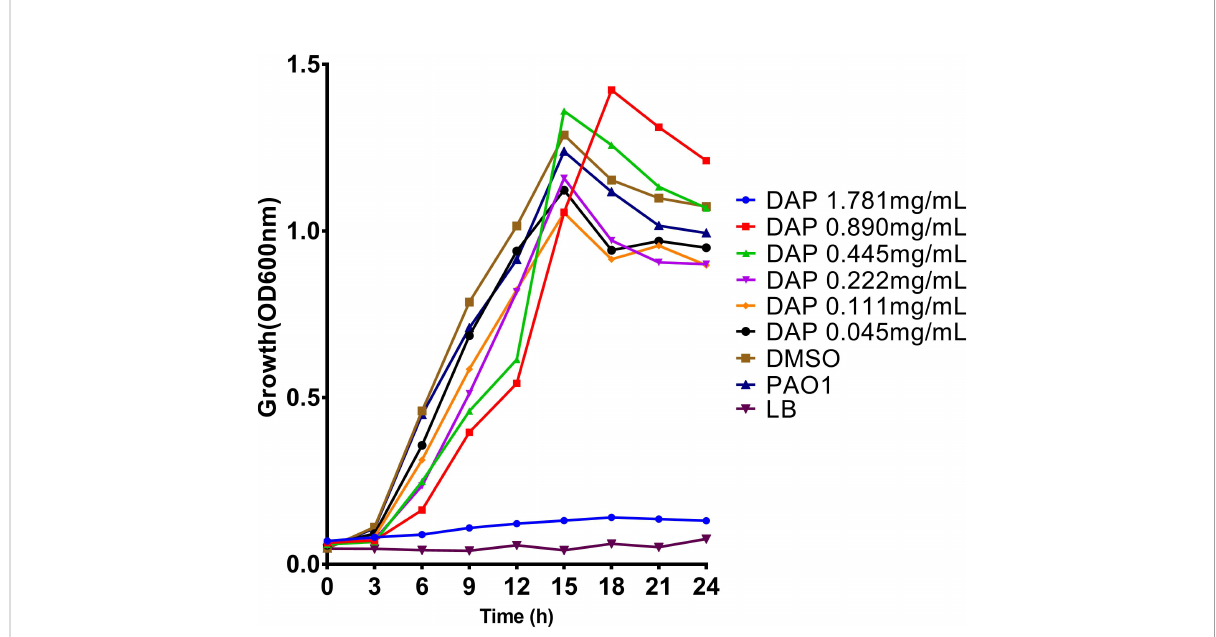
FIGURE 2 Effect of daphnetin (DAP) on the growth of P. aeruginosa within 24 h. Growth curves of P. aeruginosa PAO1 treated with different concentrations of DAP (0.055 – 1.781 mg/mL) in LB broth at 37°C for 24 h. The error bars represent the standard error of the OD 600 value for each time point on the growth curves.